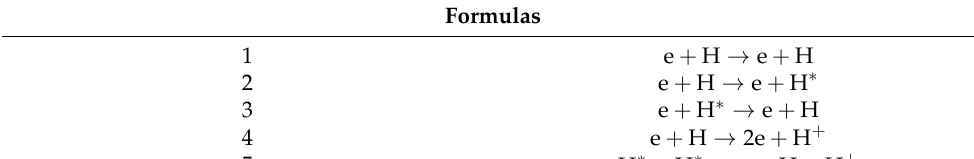
Table 2. Collisions and chemical reactions of hydrogen (H) used in the MPJCVD model. Formulas